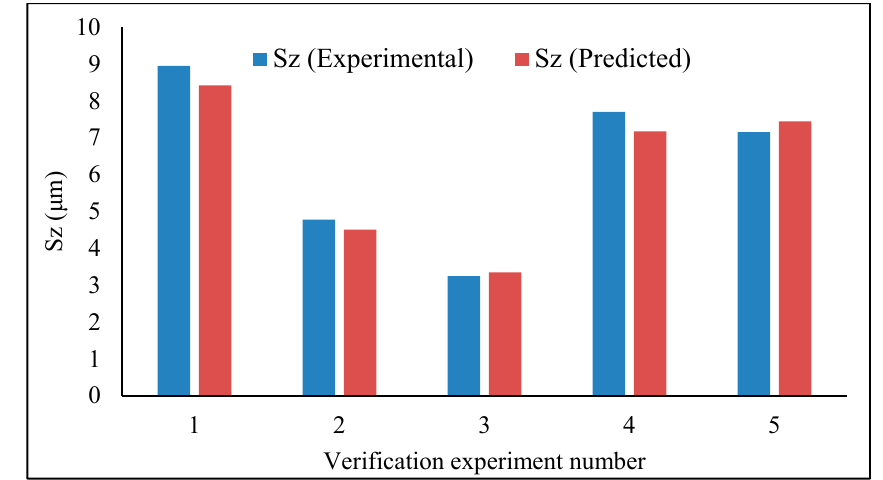
Figure 7. Average roughness parameter ( Sa ) – verification test.